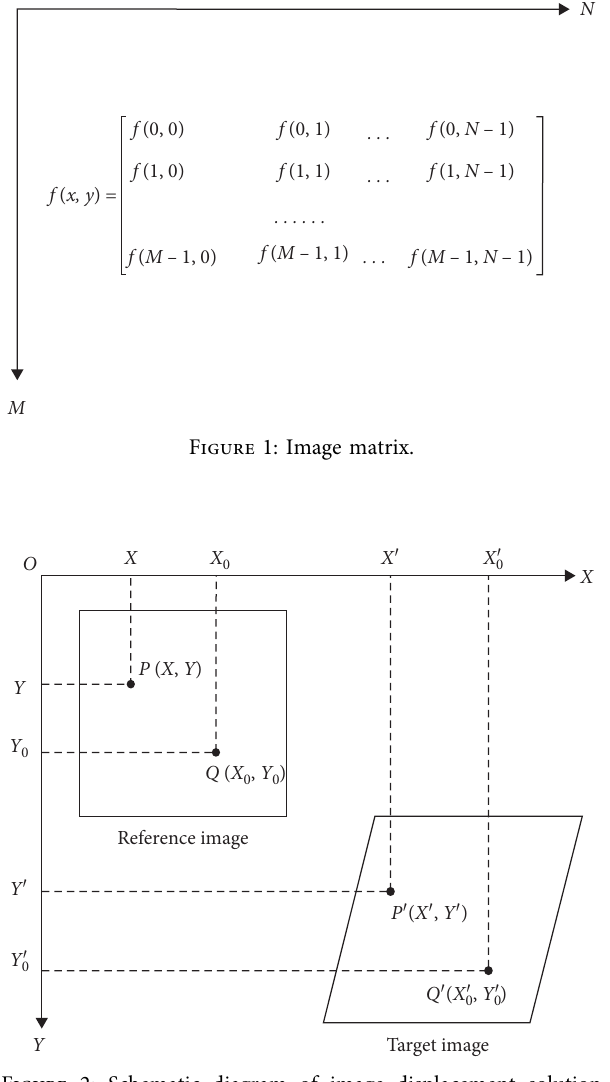
Figure 2: Schematic diagram of image displacement solution principle.